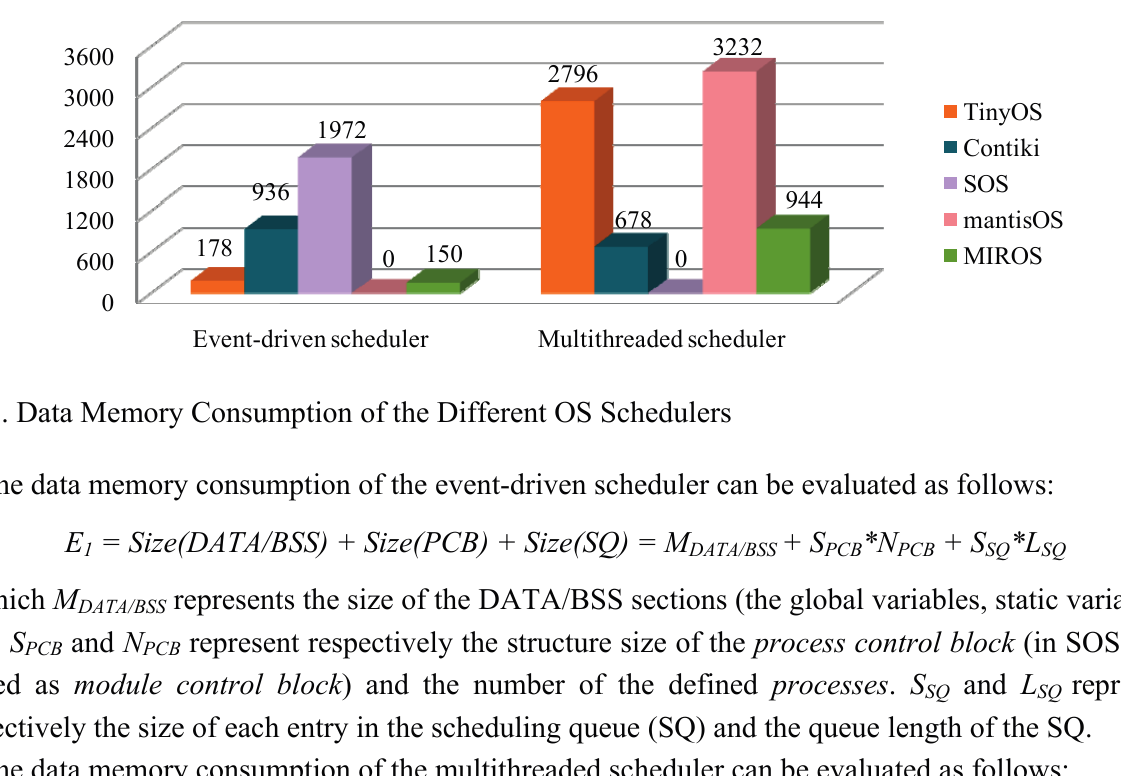
Figure 5. Code size of the event-driven and multithreaded schedulers in the different OSes